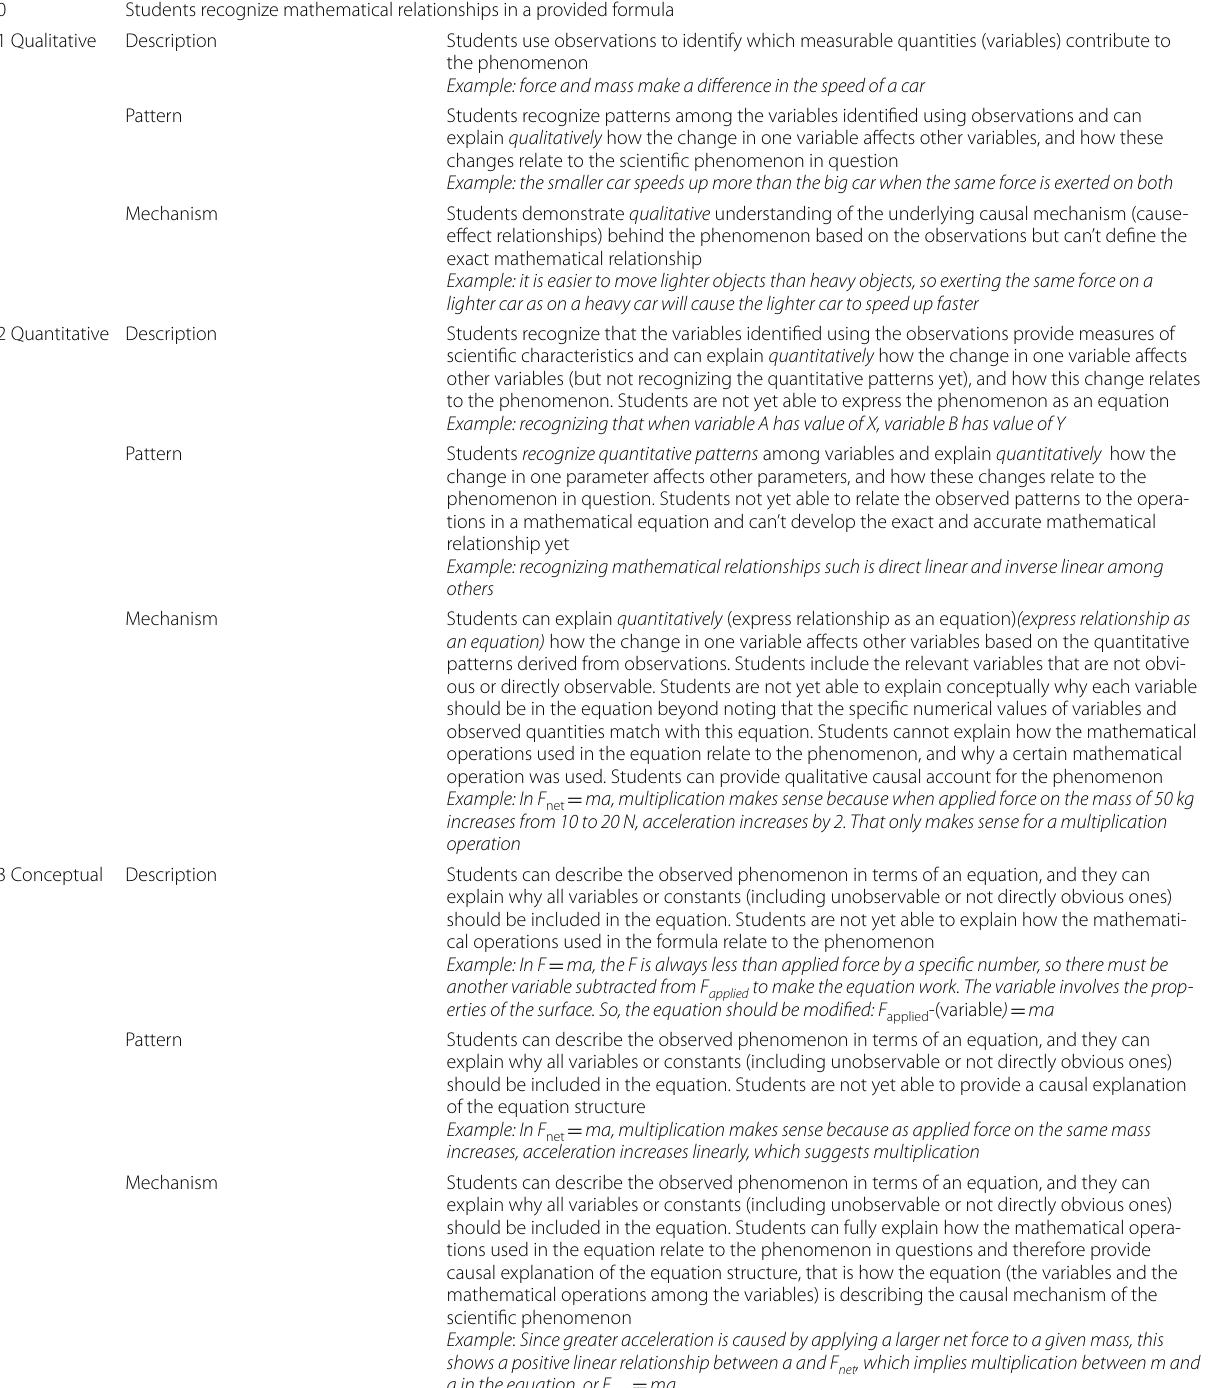
Table 1 Theoretical blended Math-Sci sensemaking